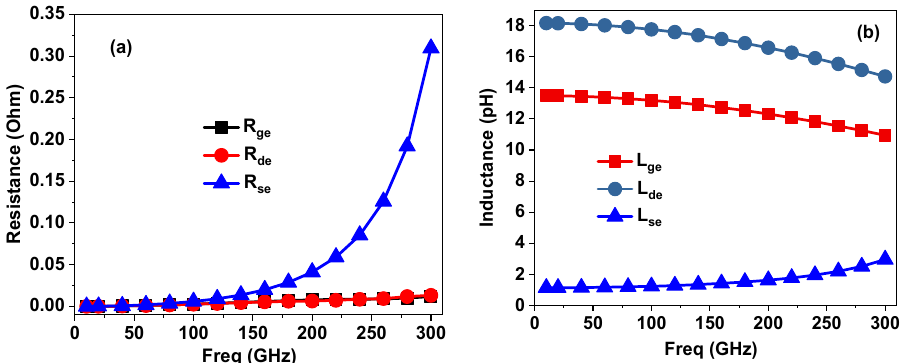
Figure 7. The resistance and inductance on the source and drain gate electrodes: ( a ) R ge , R de and R se ; ( b ) L ge , L de and L se .